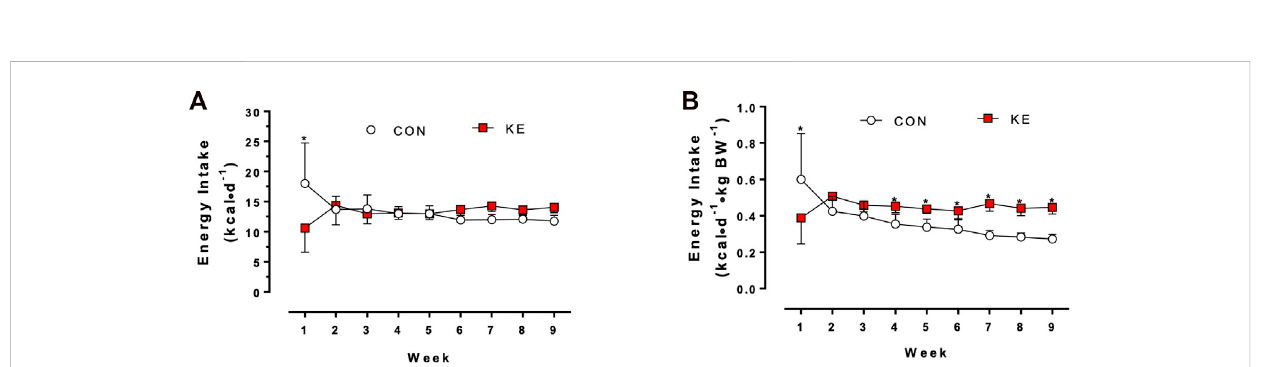
FIGURE 2 Differencesin energy intake after 9 weeks of Control (CON; HFHS)or Ketone Ester (KE; HFHS +25% ketone ester by kcals) diets. (A) Energy intake in kilocaloriespermouseperday(kcal/mouse/d).* p < 0.001atweek1; p > 0.05fortheremainderoftheexperimentalphase. (B) Energyintakeinkilocalories per gram body weight (kcal/g BW). * p < 0.05 beginning at week 4 and for the remainder of the experimental phase. Values are presented as means ±